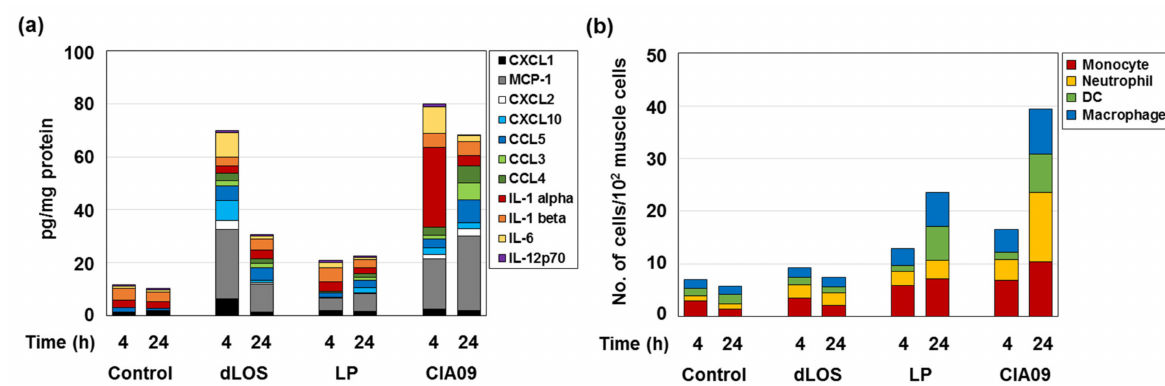
Figure 7. Cytokine and chemokine induction and immune cell recruitment at SOI. Groups of mice ( n = 3) were given an intramuscular injection with dLOS (3 µ g), liposomes (LP) (100 µ g), or both (CIA09), and muscle samples were collected at 4 h and 24 h post-injection. ( a ) Muscle tissue homogenates were prepared and analyzed for cytokines and chemokines by multiplex assays using Luminex ® . ( b ) Single cells were prepared, stained with antibodies specific for immune cell markers, and analyzed by flow cytometry. Data are expressed as the mean of three muscle samples for each group.